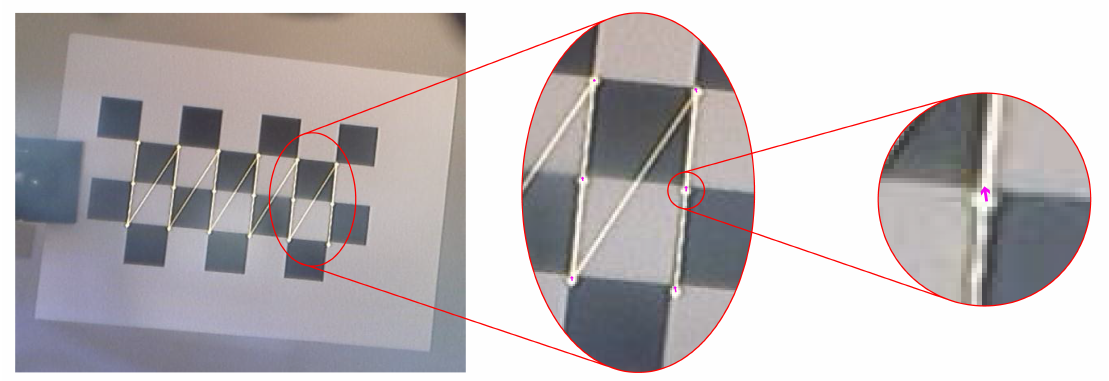
Figure 8. Image grabbed from the viewpoint camera after the calibration. The accuracy of the calibration is measured as the overlay error between the ground truth real corners of the validation checkerboard and the centers of the virtual yellow circles. The zoomed details of the image shows the on-image displacements between the real and the virtual landmarks. Red arrows indicate the direction and magnitude of overlay error in